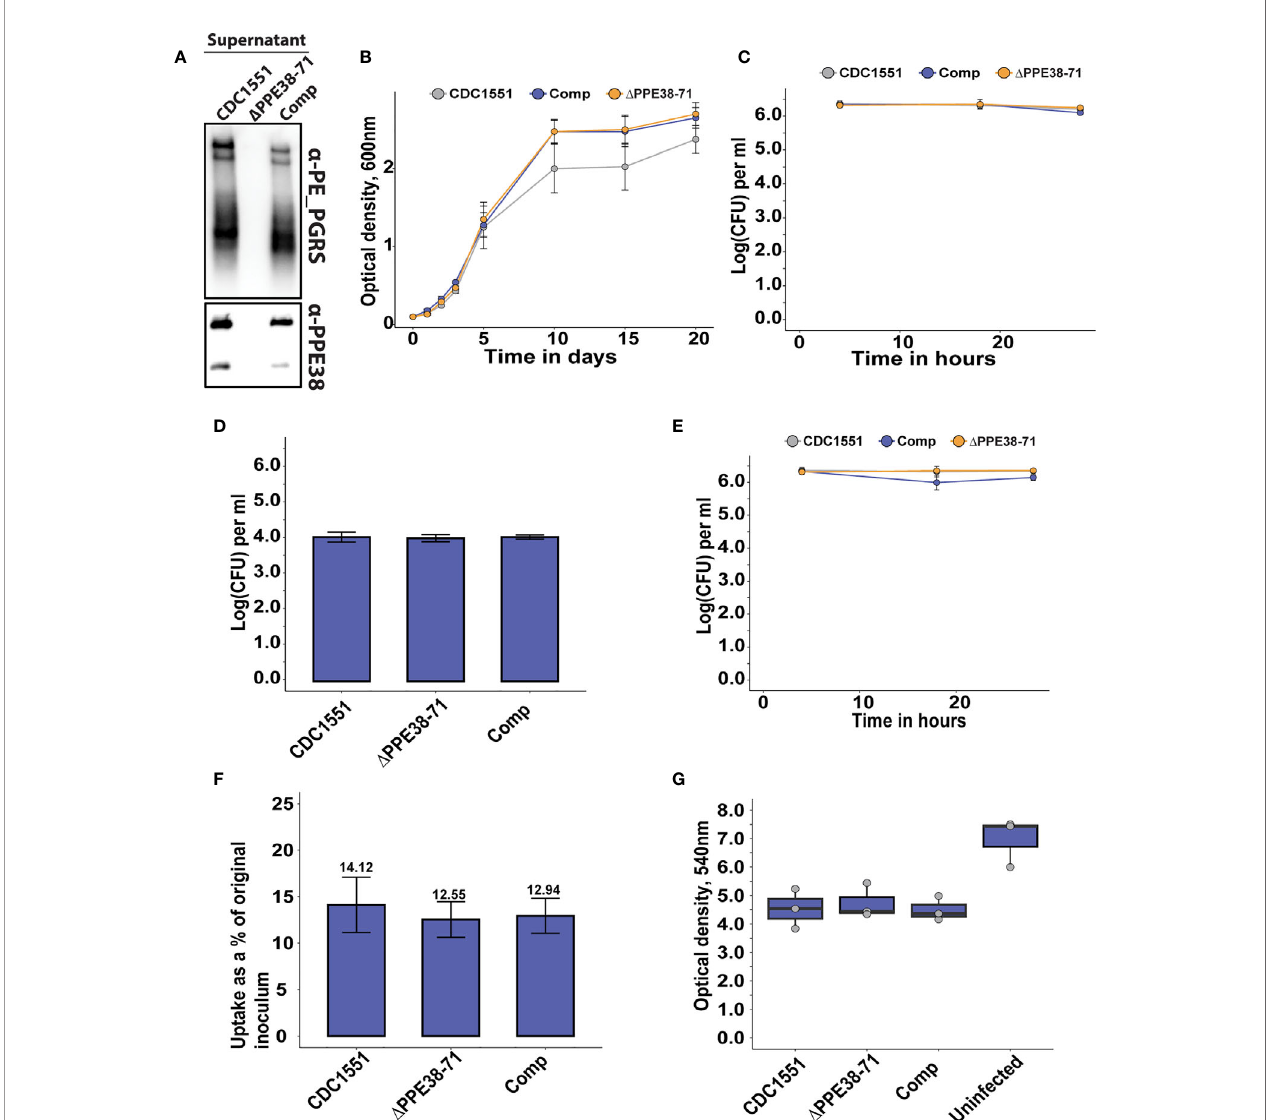
FIGURE 1 | The absence of PPE38 controlled PE-PGRS proteins has no effect on bacterial survival or macrophage death in a 28 hour period. (A) PE-PGRS and PPE38 immunoblot of in vitro culture supernatants of M. tuberculosis CDC1551, D ppe38-71 and the complemented strain harvested at OD 600 of ~1. (B) In vitro growth curves of M. tuberculosis CDC1551, D ppe38-71 and the complemented strain by optical density measurements for 20 days. Data is representative of four independent experiments and error bars represent SEM. Two-way ANOVA with Tukey HSD post-hoc testing was used to determine a signi fi cant difference with a q- value cut-off at 0.05 (C) Intracellular growth curve of M. tuberculosis CDC1551, D ppe38-71 and the complemented strain in THP-1 macrophage-like cells. Growth was monitored over 28 hours and infected macrophages were harvested at 4 hours, 18 hours and 28 hours after exposure to mycobacteria. Mycobacterial load was measured by CFU enumeration. Data is representative of three independent experiments and error bars represent SEM. (D) Extracellular bacteria at 3 hours post- infection were determined by CFU enumeration after 7 consecutive washes. No signi fi cant difference was detected by one-way ANOVA between the different strains. Data is representative of three independent experiments and error bars are indicative of SEM. (E) Differential uptake of mycobacteria by THP-1 macrophage-like cells during infection was measured by washing excess bacilli at 3 hours post-infection. Pen/Strep treatment for 1 hour was used directly before each harvesting time point, i.e. 4 hours; 18 hours and 28 hours; to remove any extracellular bacteria still present. The intracellular mycobacterial load was determined by CFU enumeration and data is representative of three independent experiments, error bars represent SEM. (F) Percent bacterial uptake calculated from the original inoculum at an MOI of 3:1. Data is representative of three independent experiments where the percentage was calculated from the mean CFU of each strain obtained from 4 hours post- infection divided by the mean CFU of the original inoculum. (G) THP-1 macrophage viability was measured by MTT assay at 18 hours post-infection. Data is representative of three independent experiments and error bars represent SEM. One-way ANOVA was used to determine signi fi cant differences with a p-value cut off of